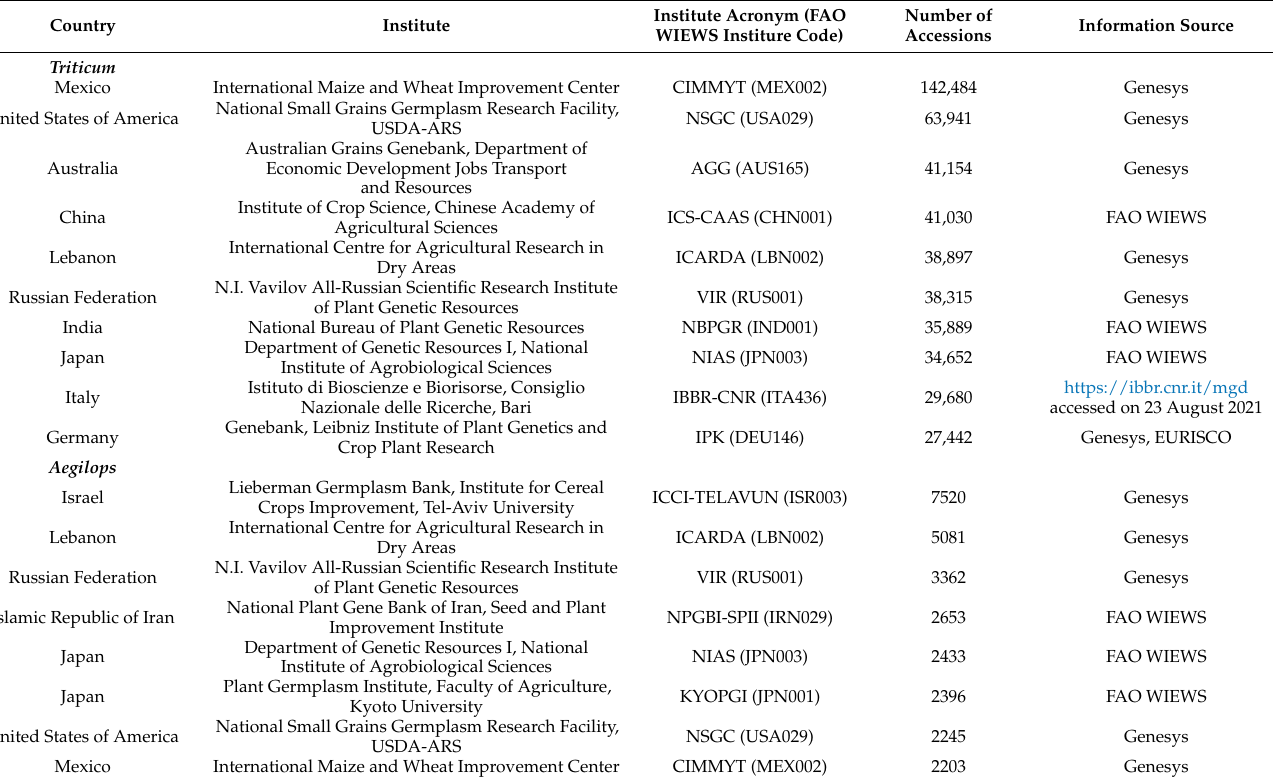
Table 1. Genebanks holding important Triticum and Aegilops collections, according to the historical FAO WIEWS